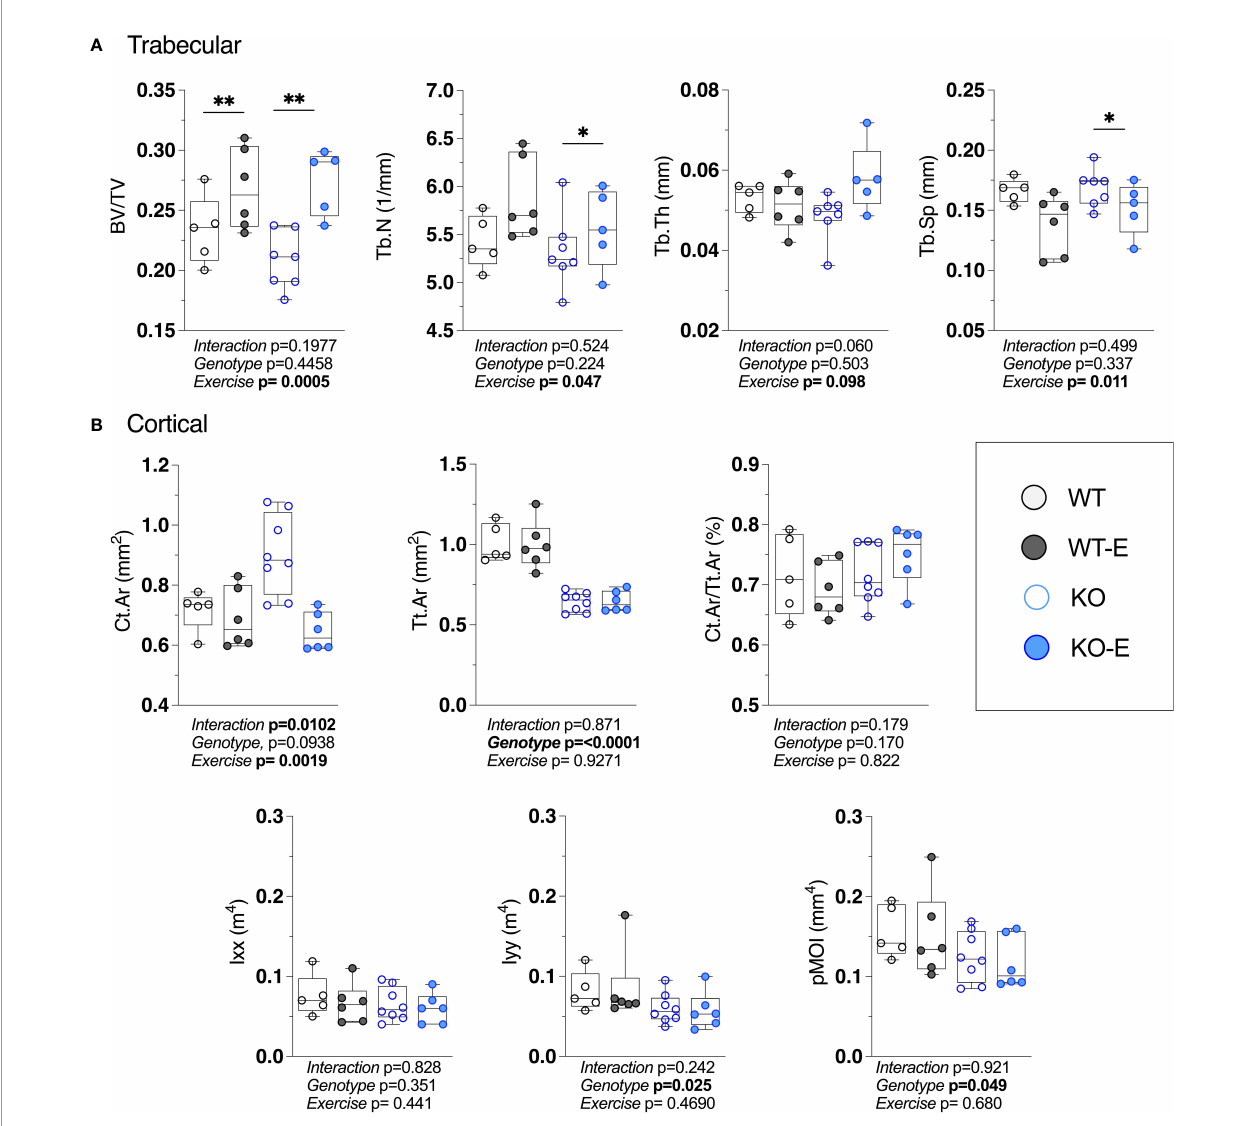
FIGURE 4 | Higher bone quantity in exercising WT and lipodystrophic SEIPIN KO mice. Twelve-week-old male SEIPIN KO and WT allocated to exercise (E) vs non- exercise for 6 weeks (n=S-8). (A) Trabecular bone microarchitecture (BV/TV, Tb.N, Tb.Th, Tb.Sp) assessed at the proximal tibial metaphysis via 1JCT. (B) Cortical geometry (Ct.Ar, Tt.Ar, Ct.Ar/Tt.Ar) and biomechanical measures (lxx, lyy, pMOI) assessed at the mid-tibial diaphysis. Data plotted as individual values with means represented by horizontal lines. Signi fi cance assessed via 2- way ANOVA, Tukey's post hoc. Signi fi cance for between-group comparisons: *p < O.OS; **p < 0.01. Data as individual values on box and whisker plots (min to max). Horizontal lines represent